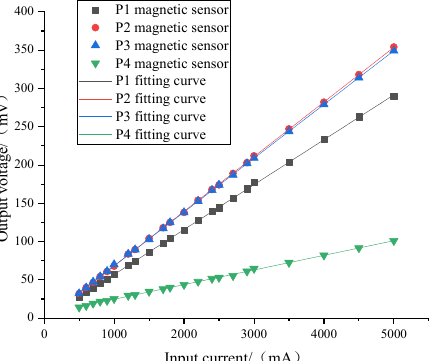
Figure 16. The input and output curves of the sensor are linearly fi tt ed.